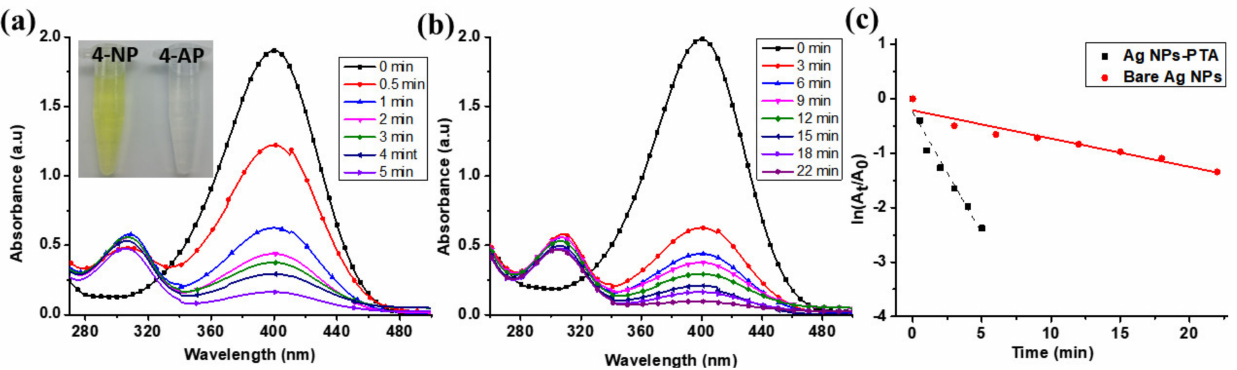
Figure 10. UV-Vis spectra of the catalytic conversion of 4-NP to 4-AP in the presence of ( a ) Ag NPs-PTA; ( b ) Bare Ag NPs; and ( c ) Plot of ln(A t /A 0 ) versus time for the reduction of 4-NP into 4-AP in the presence of Ag NPs-PTA nanocatalyst and bare Ag